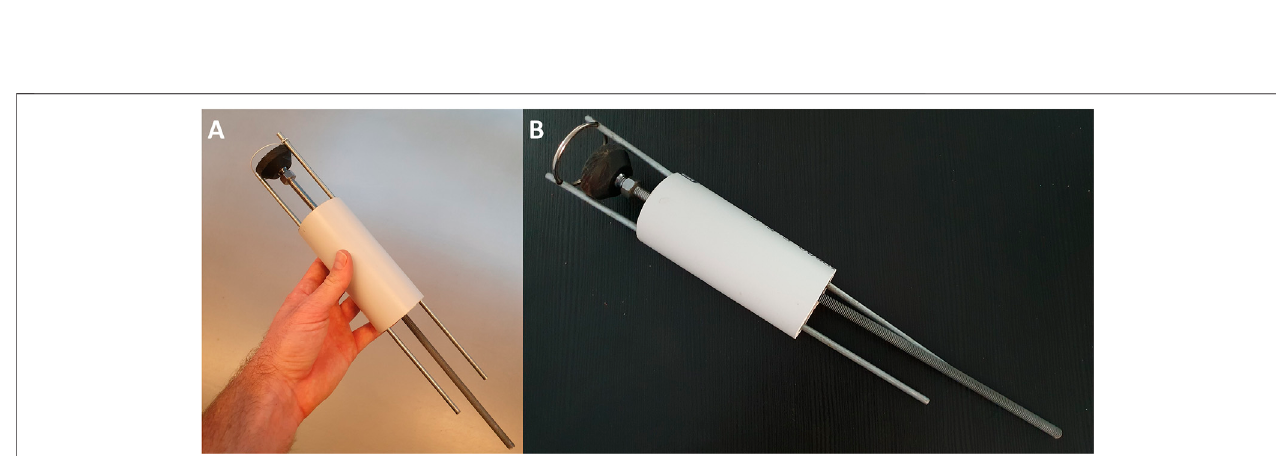
FIGURE 4 | The HeartStamp prototype for cardiac patch transplantation. The HeartStamp is designed to transplant a patch to the surface of the heart via a uniportal VATS incision. The instrument is shown prior to use at surgery with a fl exible ring and the operator ’ s hand for scale (A) and with a rigid ring after use at surgery (B) . Computer-aided design (CAD) images associated with this prototype are shown in Figure 5 .